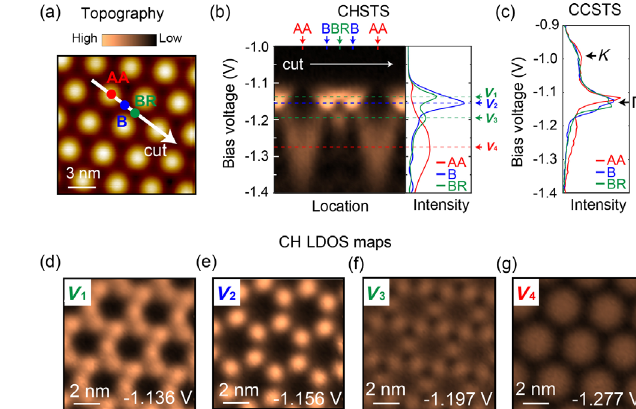
FIG. 2. ARPES measurement on TB WSe 2 . (a) Scanning photoemission microscopy (SPEM) of TB WSe 2 device. The SPEM image is generated from real-space mapping of the valence band spectra. Dashed lines of red, black, and green mark boundaries of top, bottom layer WSe 2 , and Au contact, respec- tively. The blue square marks the photon beam position during ARPES measurements. (b) Equal energy contour at binding energy E B ¼ 1 . 2 eV measured at 100 eV, overlapped with BZs of the top (red) and bottom (black) layer WSe 2 . The subscripts t and b of K valleys stand for the top and bottom layer, respectively. The bare Γ -valley pocket (of main band Γ 1 ) is indicated by the black arrow. moir´e bands (MBs) are indicated by the orange arrow. (c) Band dispersion across K t point measured at 100 eV. (d) Band dispersion across K t point measured at 74 eV. (e) Band dispersion across Γ points measured at 100 eV. (f) Band dispersion along k y at k x ¼ − 0 . 3 Å − 1 (around Γ valley) mea- sured at 100 eV. In (c) – (f), the inset red hexagons are the BZs of top layer WSe 2 , showing the sample orientation, and red arrows present the directions of dispersions with respect to BZs. In (e) and (f), Γ 1 and Γ 2 stand for two main bands of bilayer WSe 2 , MBs are indicated by orange arrows, δ k is the momentum spacing between MBs and Γ 1 .